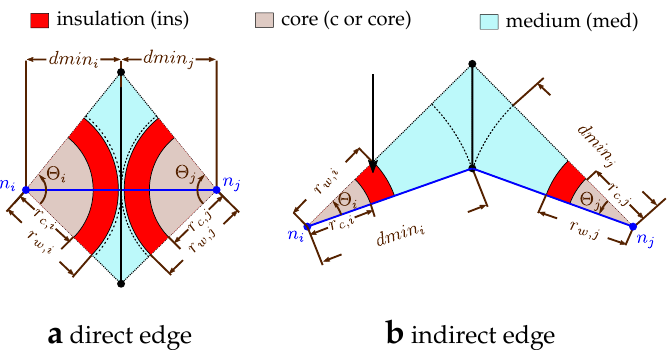
Figure 5. Cutting an internal cell with the 2 possible cases: direct edge ( a ) and indirect edge ( b ).